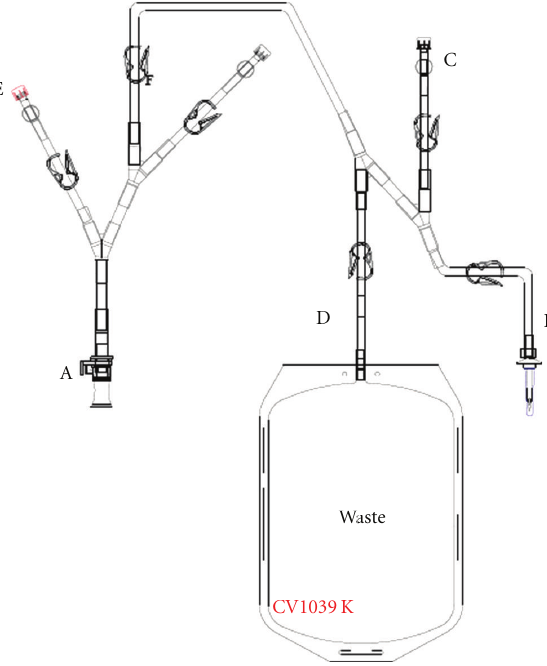
Figure 3: Set of tubing with waste bag for cell